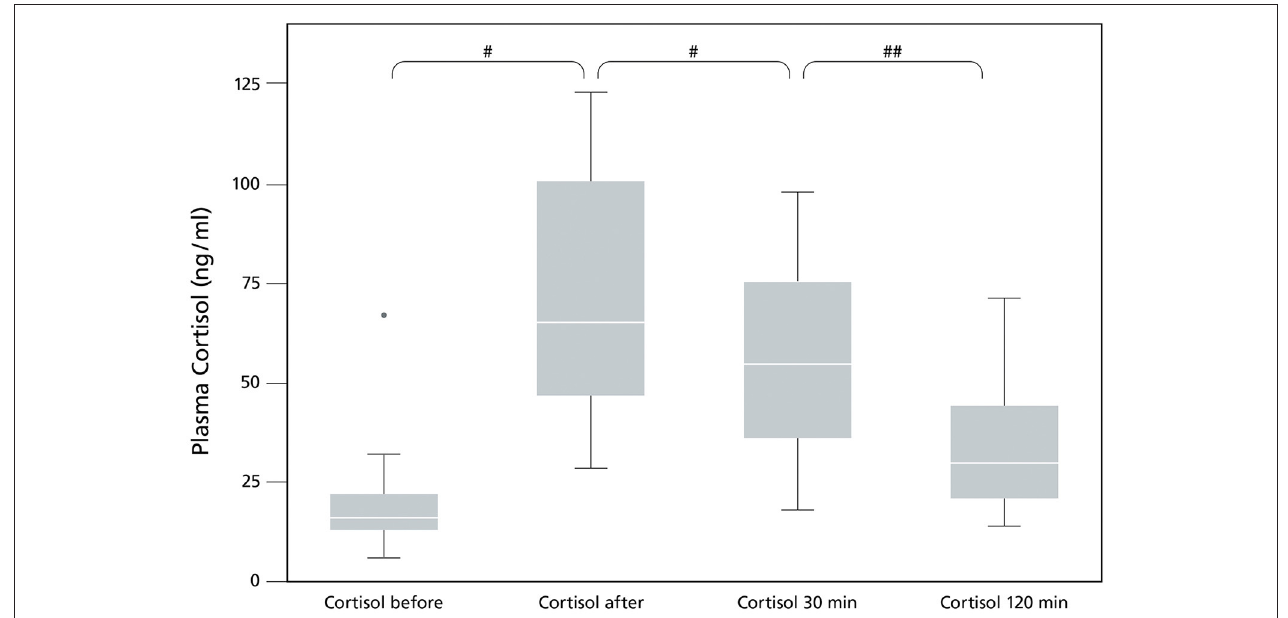
FIGURE 1 | Plasma Cortisol levels (ng/ml) in sled dogs before and after endurance exercise (pilot study). The data ( n = 17) are displayed as boxplot showing the first (25%), the median (50%) and the third quartile (75%). The whiskers are displaying values within 1.5 times the interquartile range (IQR). Outliers are shown separately. Outliers are plotted as individual points. # p < 0.001, ## p = 0.013.